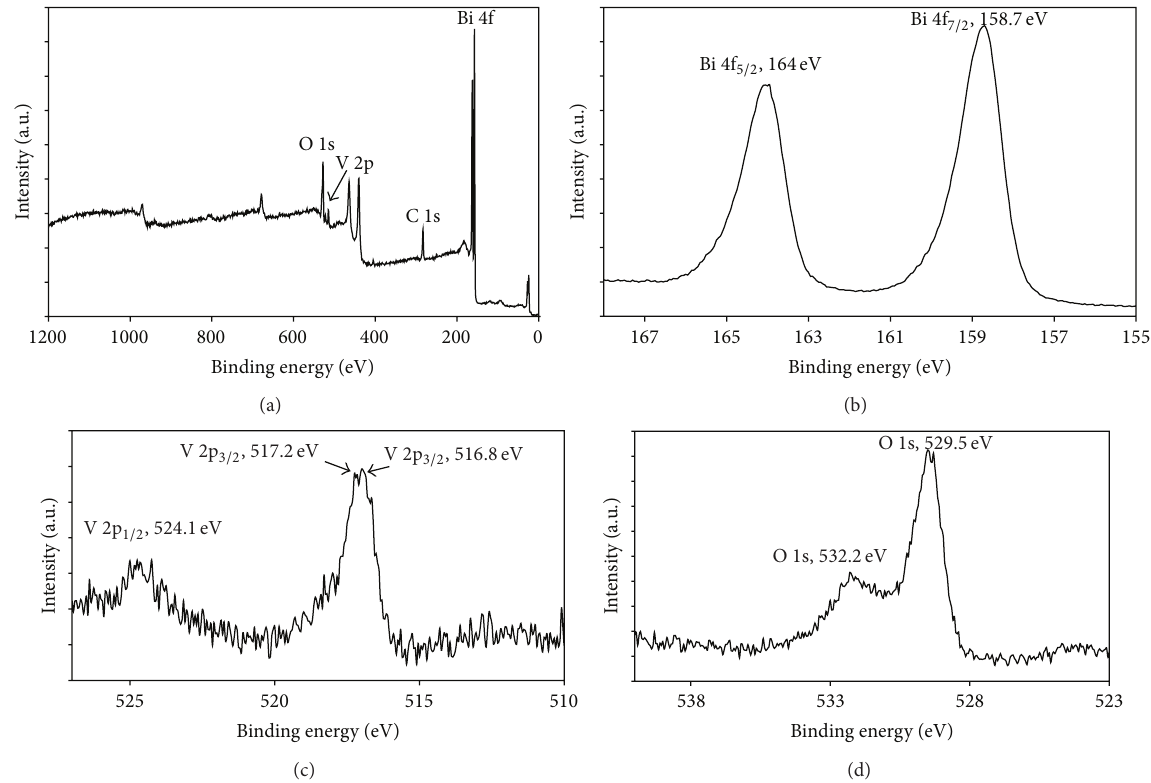
Figure 5: Full-scan XPS spectrum of BiVO 4 (C+H-200-24) and high resolution spectra of Bi 4f, V 2p, and O 1s. (a) Full scan of BiVO 4 , (b) Bi 4f, (c) V 2p, and (d) O 1s.